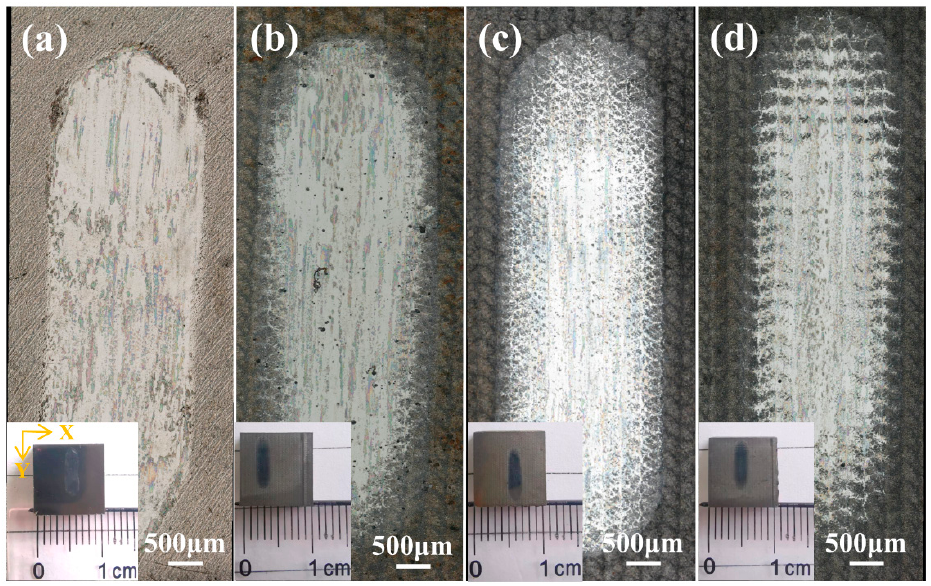
Figure 9. OM morphologies of wear and tear. ( a ) base material; ( b ) 50 mJ; ( c ) 150 mJ; ( d ) 200 mJ.